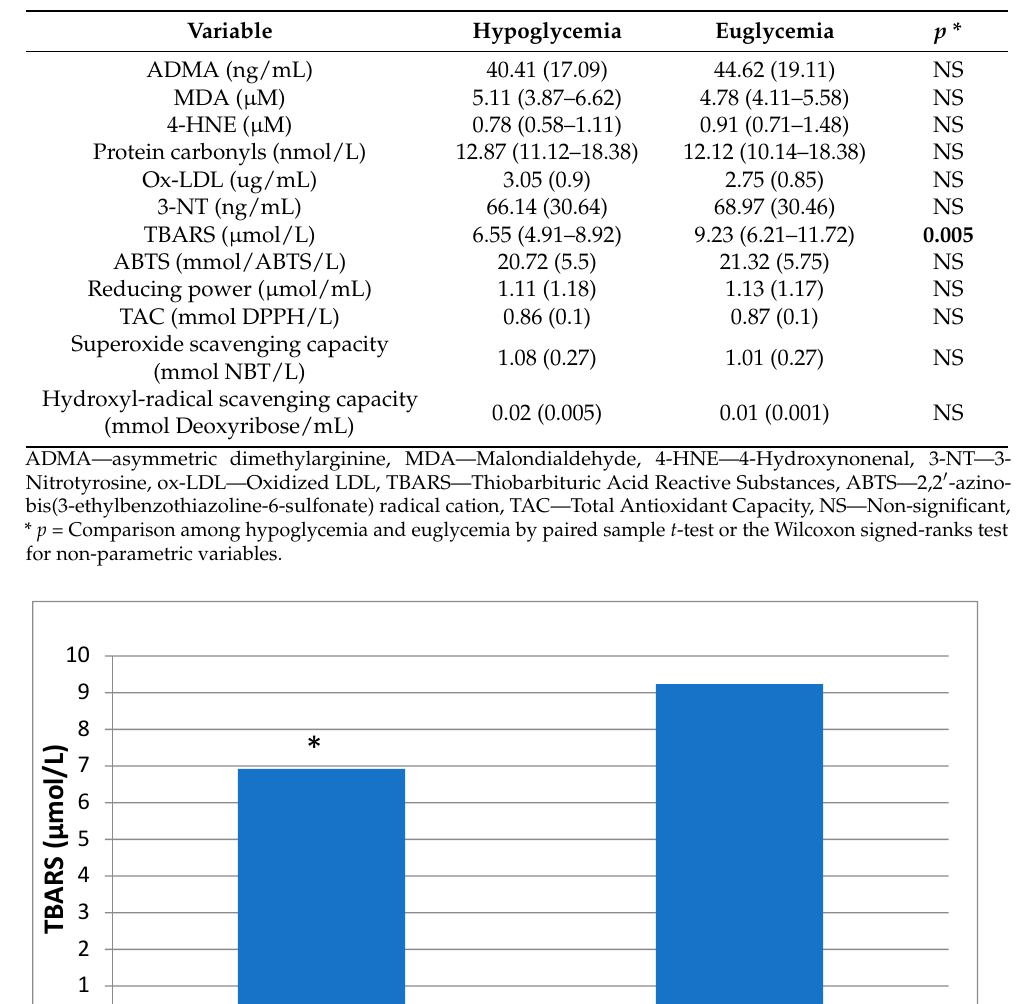
Table 2. Comparison of oxidative stress biomarkers and antioxidant capacity indices between hypoglycemia and euglycemia [mean ± SD for normally distributed variables or median (IQR) for non-normally distributed variables].